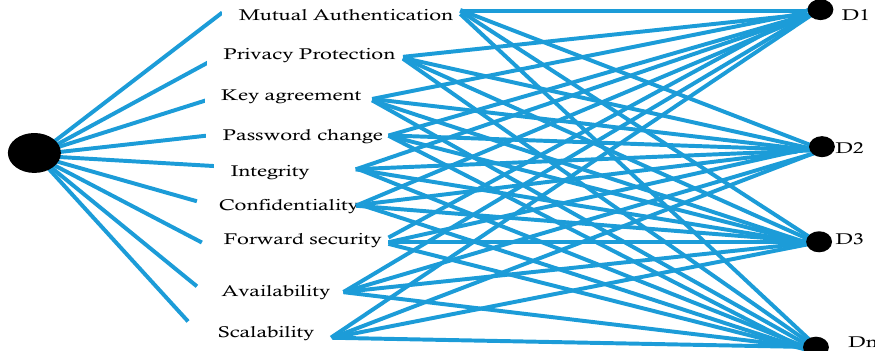
Figure 2. Authentication features frequency of occurrence.